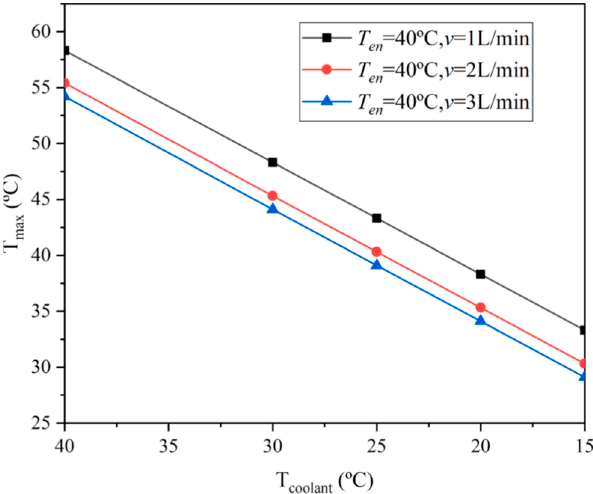
Figure 8. Variation of T max at a 4 C discharge rate with different coolant temperatures (from Li et al. [54], with permission from Elsevier).